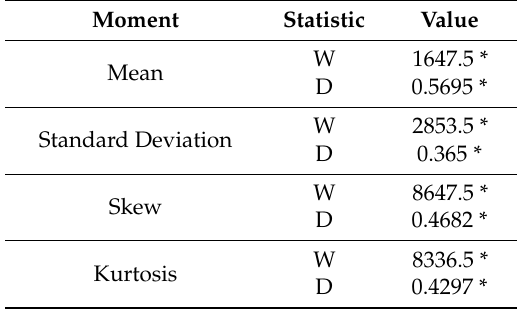
Table 1. Test of similarity between Snow (P1S1) and rain (P1S0) reflectance distribution moments (W: